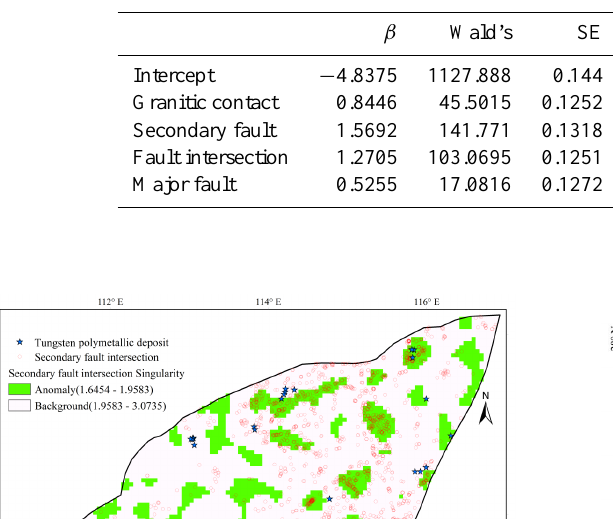
Table 1. Coefficients of the logistic regression and corresponding statistical indicators of significance of four binary singular map predictors.